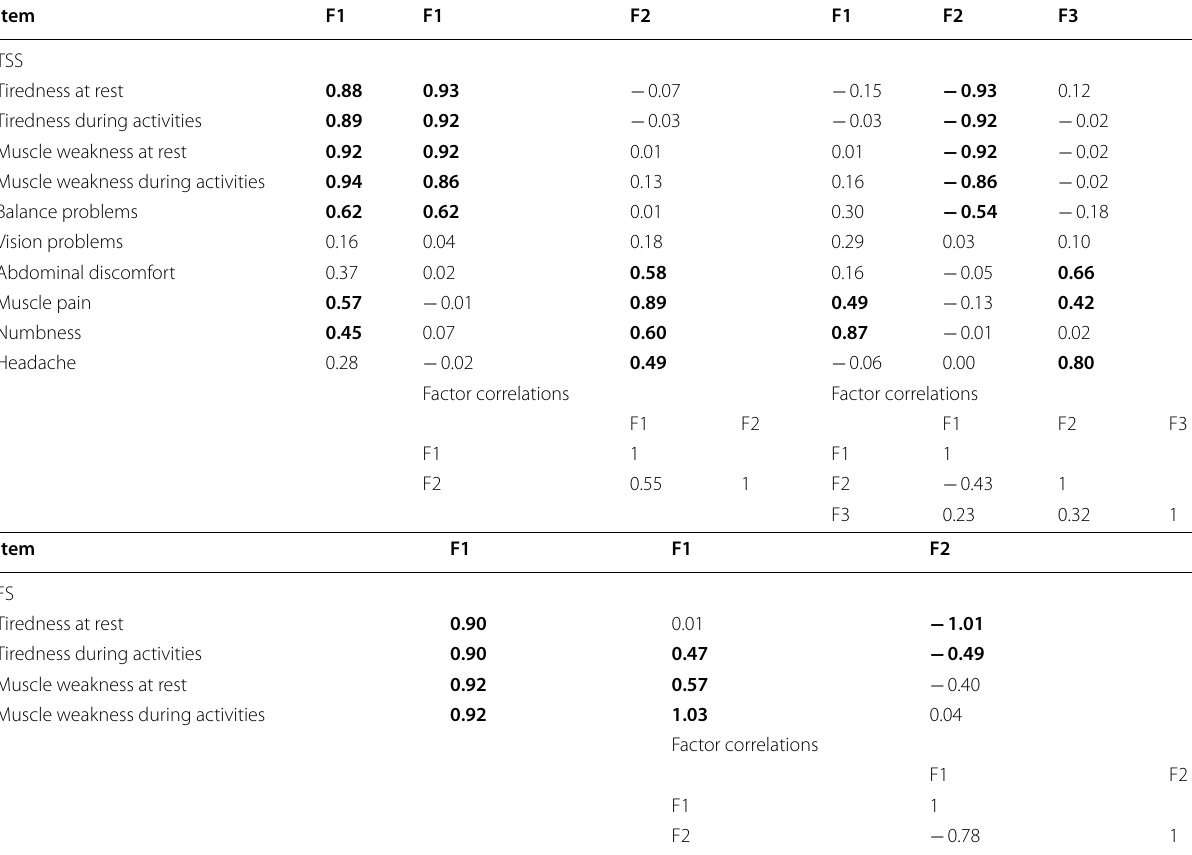
Table 4 Item loadings and factor correlations from exploratory factor analyses of the PMMSA items, for both the 10-item TSS and